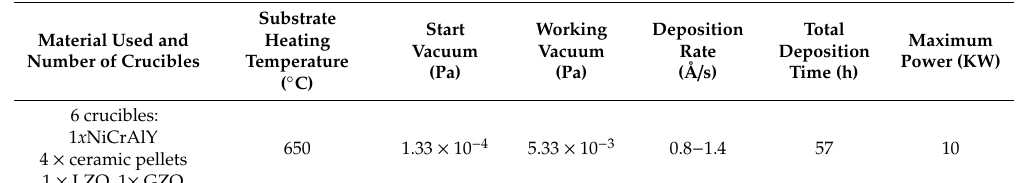
Table 6. Working conditions and parameters.